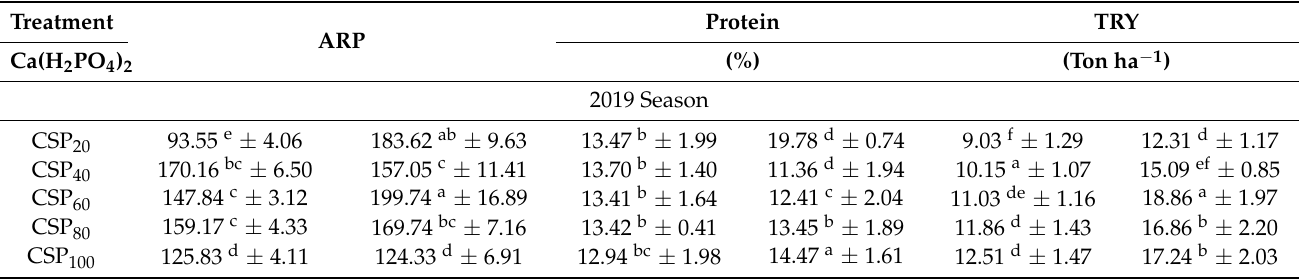
Table 8. Influence of interaction between phosphorus fertilizer and Bacillus megaterium DSM 2894 var. on anti-radical power, protein content, and total roots yield of sweet potato plants grown on calcareous saline soil in 2019 and 2020